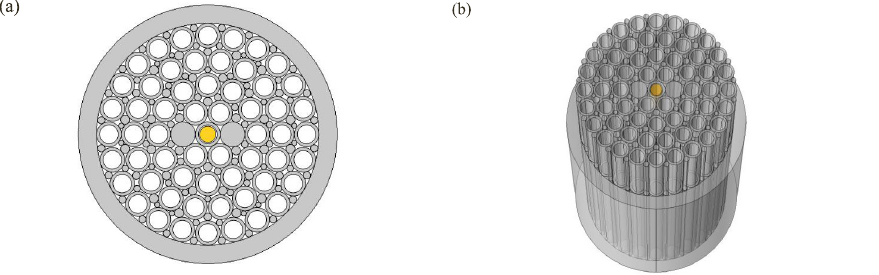
Figure 2. Circular double-core PCF preform, ( a ) two-dimensional end view of the preform, ( b ) three- dimensional view of the